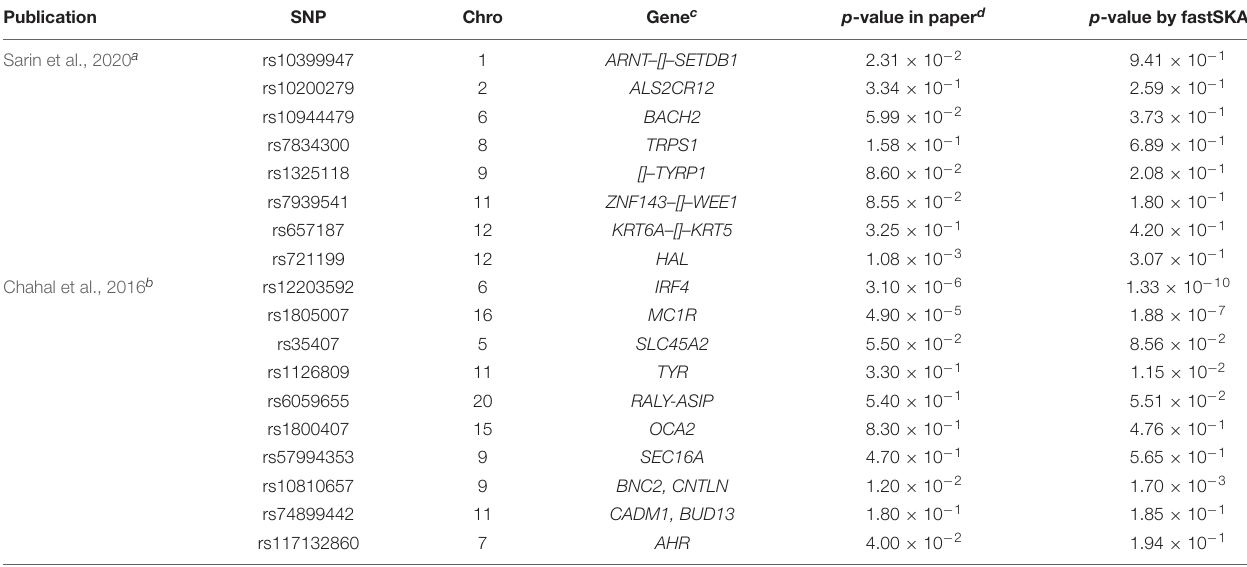
TABLE 2 | Comparison of p -values for 18 SNPs identified by published GWASs and computed by